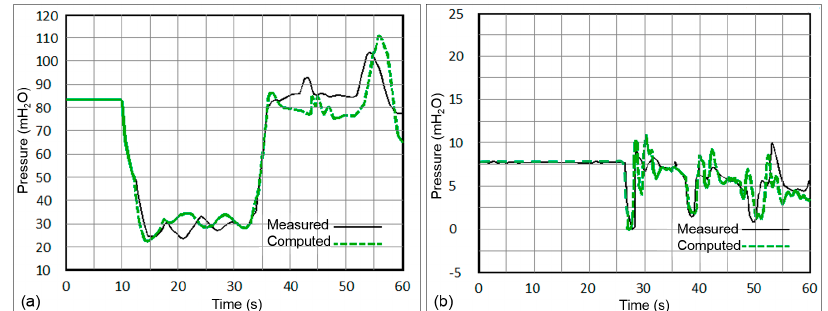
Figure 14. Measured and computed pressure traces ( a ) at discharge header of Pumping Plant 2 and ( b ) at the air valve located at station 38 + 800.